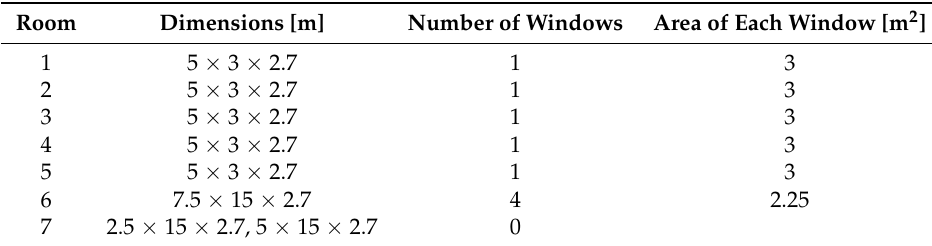
Figure 3. The seven rooms flat used as a benchmark. The corresponding room number is written in black. Table 1. Characteristics of the considered building. Rooms are numbered starting from the most southeastern one and following the anticlockwise direction.